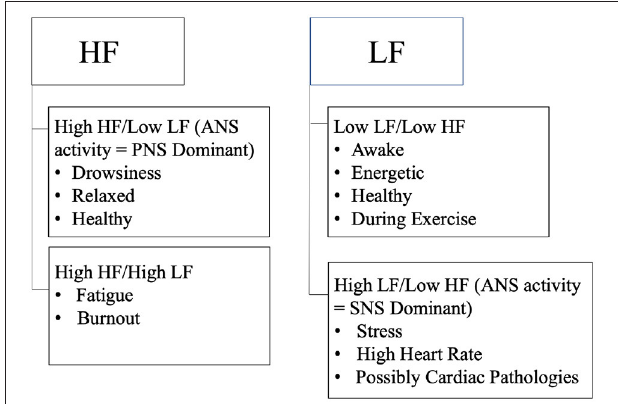
FIGURE 7 | Describes LF and HF associated with stress, drowsiness, awake, and